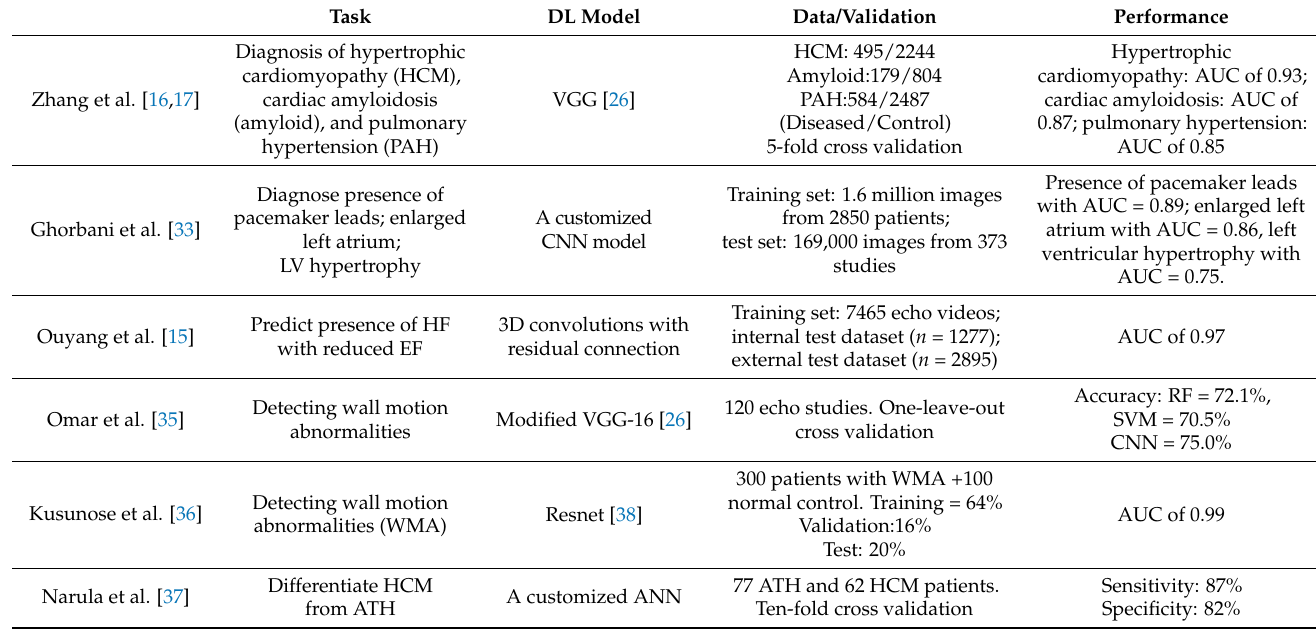
Table 4. Deep-learning-based AI studies for disease diagnosis. AUC: area under the